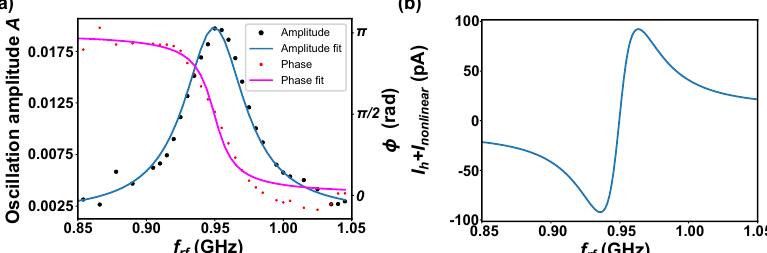
Figure 4. ( a ) Simulated amplitude and phase of magnetization precession A at the vortex core as a function of frequency for an excitation rf current of 80 nA; ( b ) Simulated homodyne